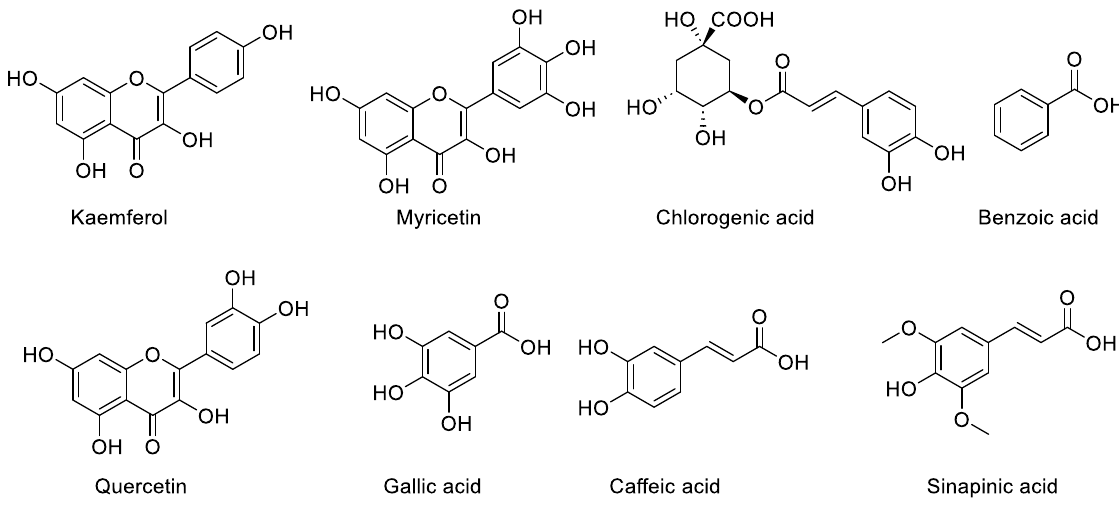
Figure 3. The chemical structure of the phenolic compounds. Figure 2. The chemical structure of the phenolic